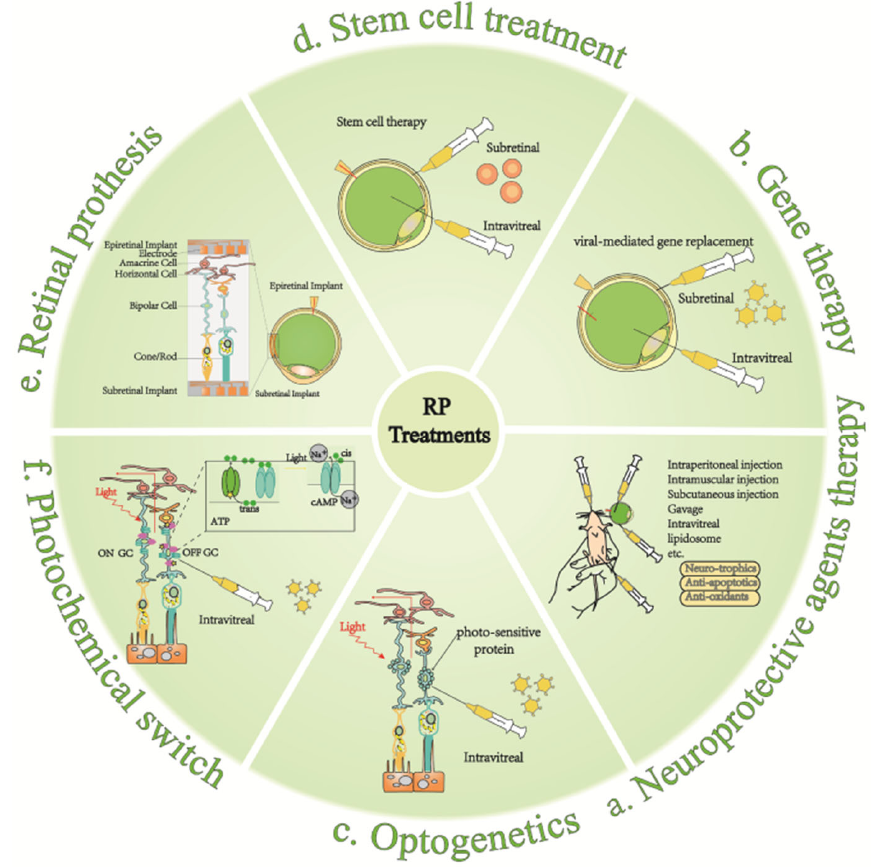
Figure 5. Six current treatment strategies for retinitis pigmentosa (RP). ( a ) Neuroprotective agents mainly include neurotrophic factors, anti-apoptotic agents, and antioxidants; they are usually used in the early stages of the disease and can also serve as the adjunctive treatment in other stages; ( b ) Gene therapy takes effect via the virus-mediated injection of a therapeutic gene tool into the retina in vitro to replace the disease-causing gene; ( c ) Introducing photosensitive optic proteins into the degenerated retina for ectopic expression in damaged cell membranes to restore the cone function and conferring photosensitive ability to residual retinal cells, such as bipolar cells or ganglion cells; ( d ) Injecting neural stem cells cultured in vitro into the retinal injury site induces differentiation into the injured cell type and replacement of injured cells, with the remaining retinal neurons forming synaptic connections; ( e ) Retinal prosthesis implantation at the site of retinal damage; the implantation sites of the artificial retina vary from subretinal, epiretinal membranes to intra-scleral; ( f ) injecting residual non-photoreceptor cells with genes that express ion channel proteins, and attaching “photoswitches”— chemical molecules that change shape when exposed to light—to the ion channel Table 2. Neuroprotective agents in pharmacological treatment.